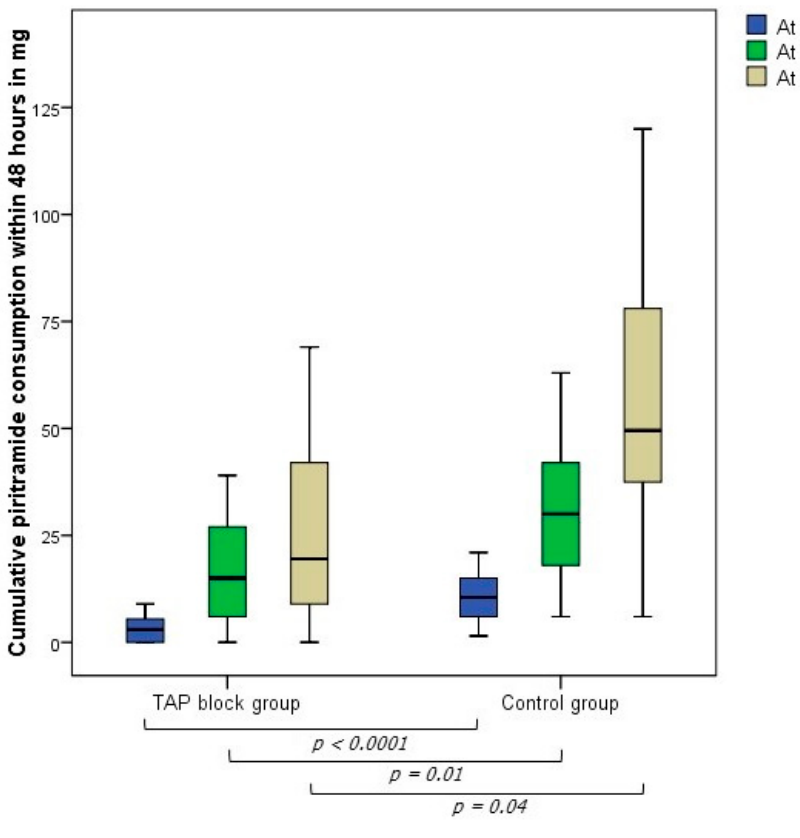
Figure 1. Cumulative piritramide consumption within the first 48 h postoperatively in the TAP block and control group in mg.